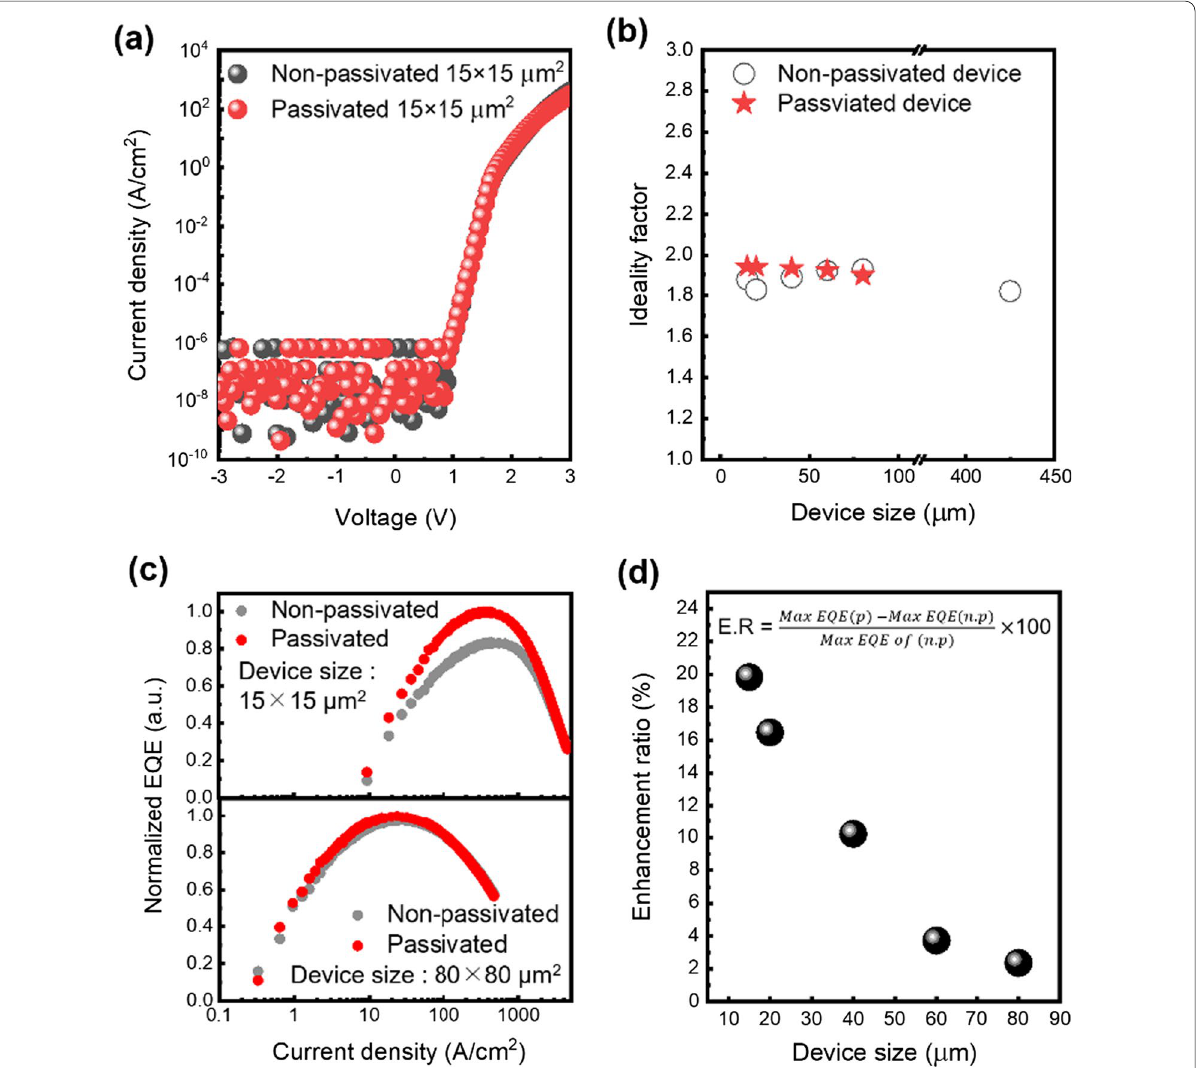
Fig. 2 a J–V curves of non‑passivated and passivated 15 AlGaInP/GaInP LEDs which have the size of 15 with passivation depending on the device